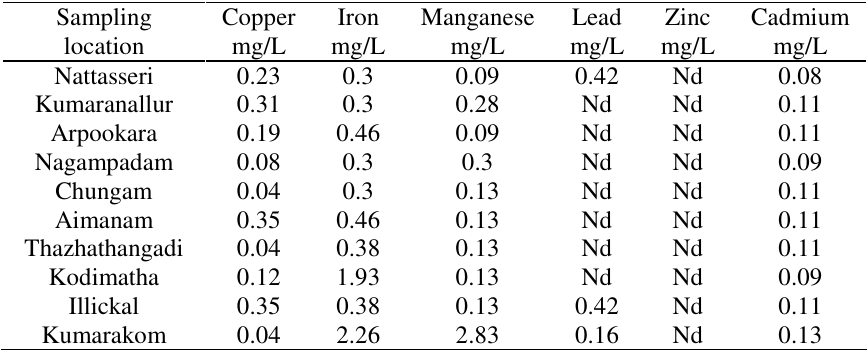
Table 2. Trace metal content of Meenachil river at Kottayam during pre-monsoon Sampling